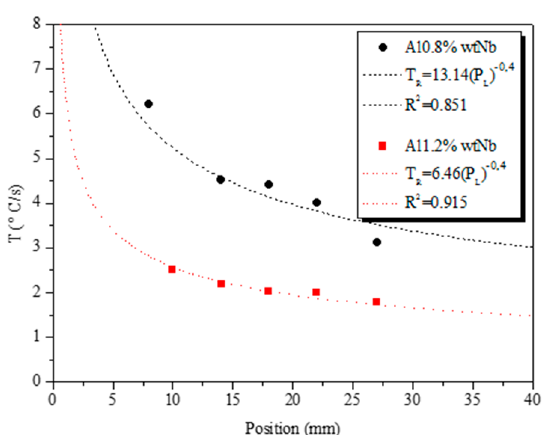
Figure 4. Cooling rate as a function of position from the metal/mold interface.